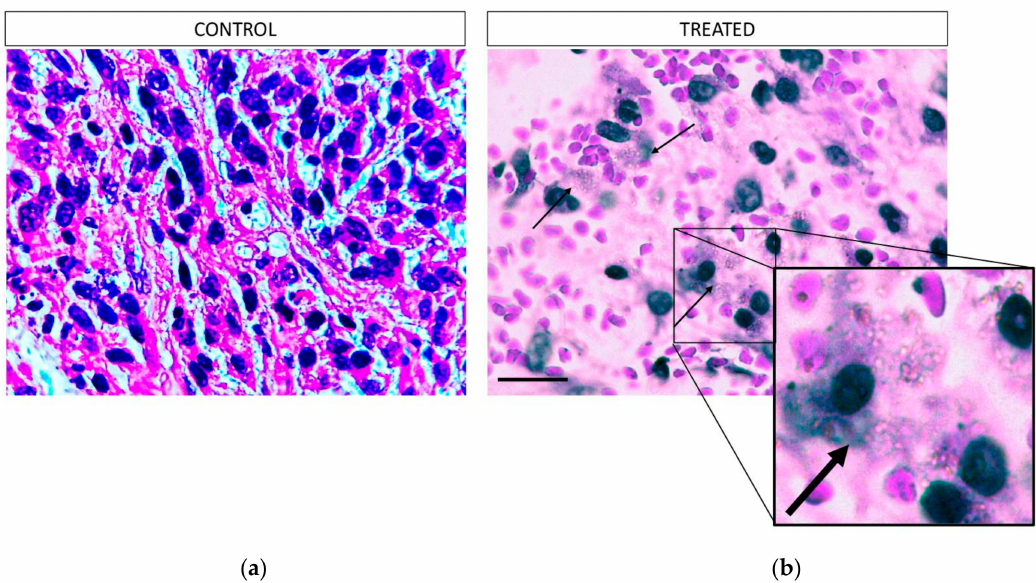
Figure 7. Representative images of H&E-stained slices of U-87 MG tumor tissue after the therapeutic e ffi cacy study in mice, from the area of the necrotic lesion (100 × magnification): ( a ) control mice, ( b ) treated mice. The arrows indicate the presence of nanoparticles in periphery of the necrotic lesions of the treated tumors. The box shows a 5 × digital zoom of the selected area. Scale bar = 40 µ